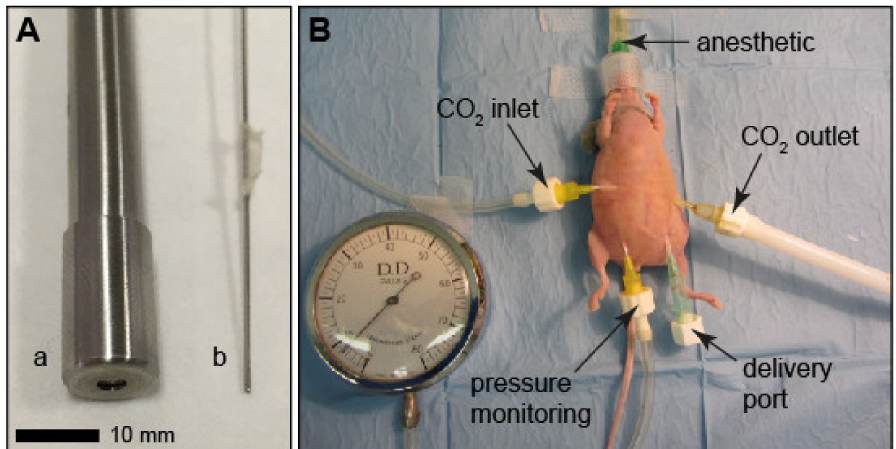
Figure 3. Setup for pressurized intraperitoneal aerosol chemotherapy (PIPAC) delivery in mice using the micro-nozzle. ( A ) Comparison of the CapnoPen ( a ) and the micro-nozzle ( b ). Scale bar, 10 mm. ( B ) PIPAC setup showing an anesthetized BALB / c nude mouse placed on a heating pad (under the blue cover) and with all ports (CO 2 inlet and outlet, pressure monitoring, and the delivery port through which the micro-nozzle is inserted).